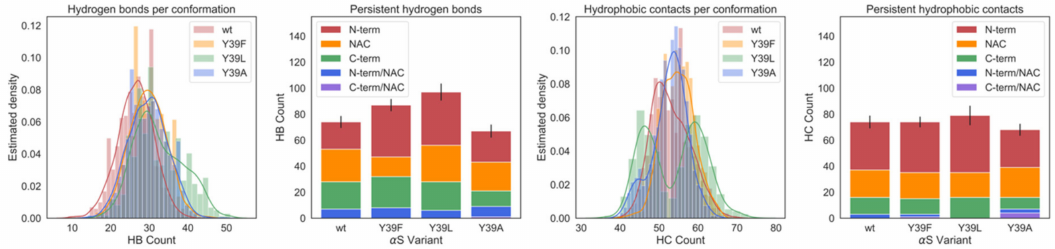
Figure 6. Hydrogen bonds (HB) and hydrophobic contacts (HC) of the four species investigated here. First panel from the left: distribution of HB contacts, with average values of 26.5, 29.6, 32.4, and 29.6 for wt , Y39F, Y39L, and Y39A α S, respectively. Second panel: HB contacts in each protein region. An HB contact was assumed to be present if persistent for 8% of the simulation or longer. Third panel: Distribution of HC contacts, with average values at 53.0, 54.8, 53.8, and 52.7 for wt , Y39F, Y39L, and Y39A α S, respectively. Fourth panel: HC contacts in each protein region. The HC contacts were assumed to be present if persistent for 15% of the simulation or longer. In the second and the fourth panels, error bars are reported. They were computed from the standard deviations of the distributions in the first and the third panels,